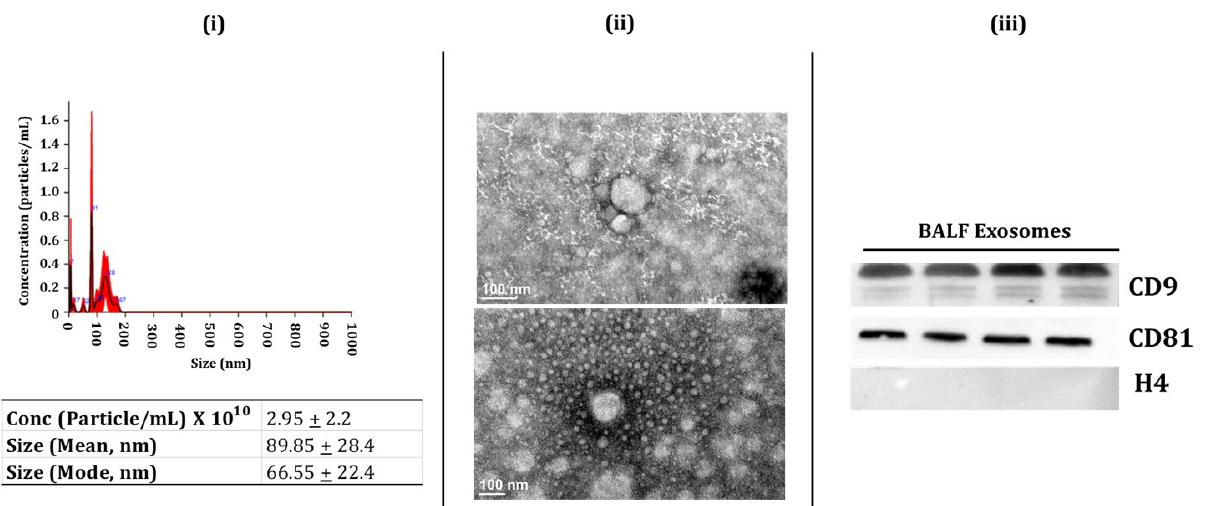
Figure 1. Characterization of human BALF-derived Exosomes (i.e., exosome-enriched EVs). ( i ) Representative image for particle size distribution of BALF-derived exosome in one sample as estimated using NanoSight NS300. Average particle size depicted as mean, mode, and particle concentration in BALF-derived exosome samples ( n = 3–8/group). ( ii ) Representative TEM images of BALF-derived exosomes ( n = 3). ( iii ) Immunoblot analysis of positive (CD9 and CD81) and negative (H4) exosomal markers derived from human BALF ( n = 4).